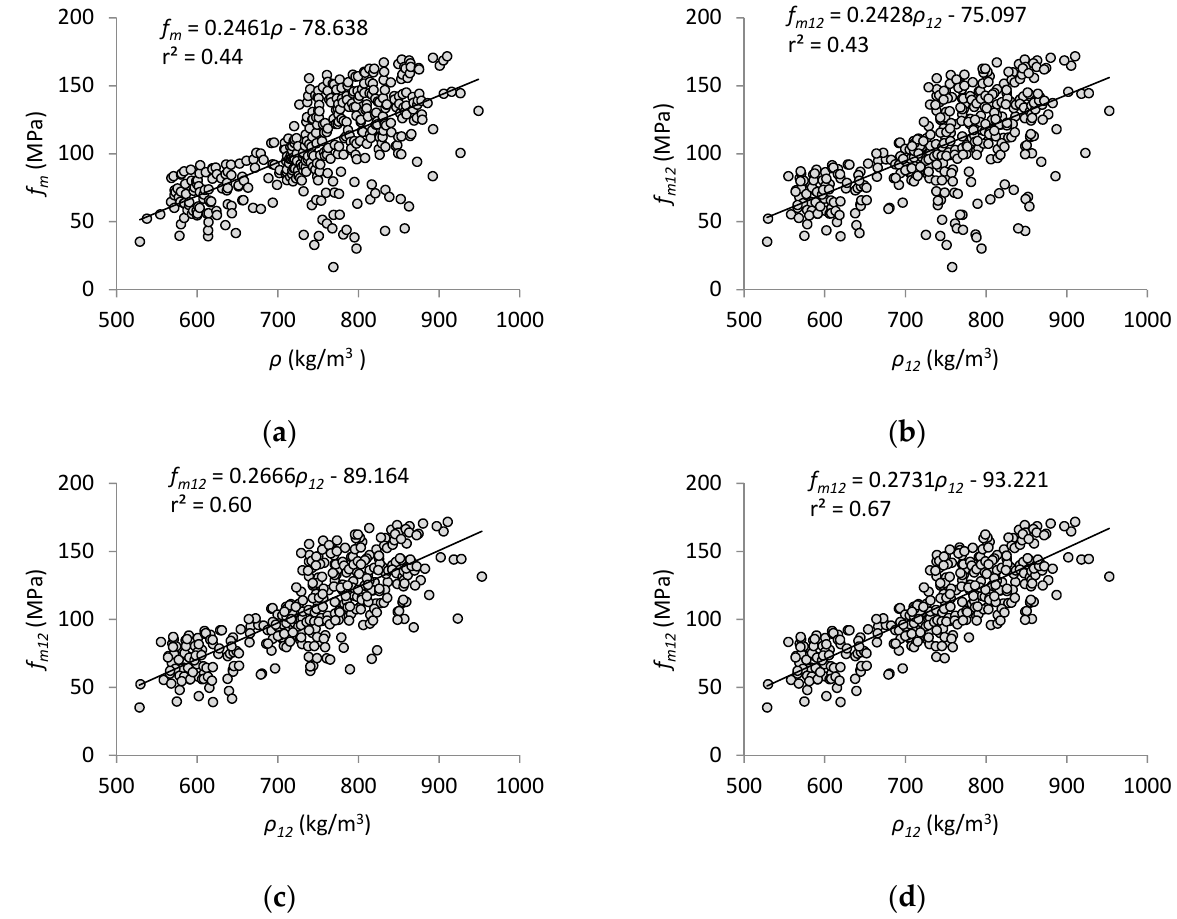
Figure 4. Correlation between density ( ρ ) and bending strength ( f m ): ( a ) With the moisture content at the time of the tests (Phase 1); ( b ) After the correction for a 12% of moisture content (Phase 2); ( c ) After excluding the outliers (Phase 3); ( d ) After excluding 5% of the values farthest from the linear regression expression. Table 5. Correlation between density ( ρ ) and bending strength ( f m ).